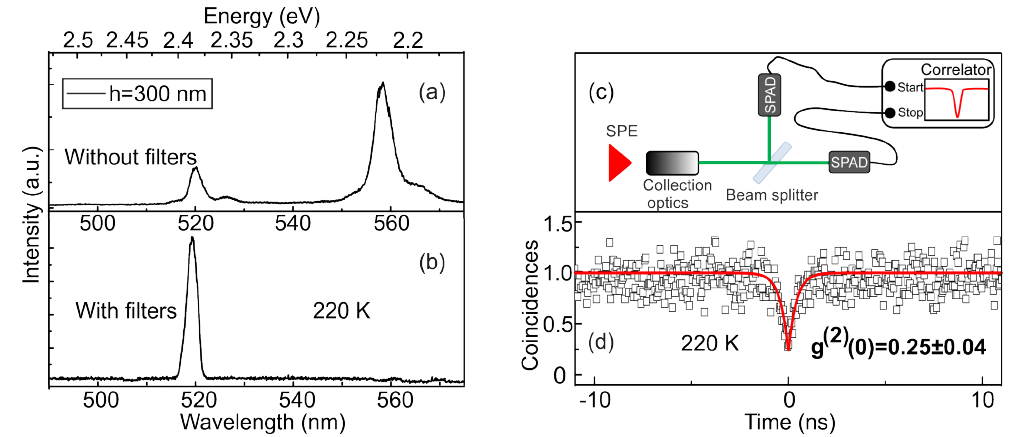
Figure 4. ( a , b ) Representative µ –PL spectra of a photonic nanoantenna with CdSe QDs, measured at 220 K without ( a ) and with ( b ) tunable long-pass and short-pass optical filters. ( c ) Schematic representation of the Hanbury Brown and Twiss setup used for measuring the second-order correlation function g ( 2 ) . ( d ) Normalized second-order correlation function g ( 2 ) of single photon emission, measured at 220 K for a spectrally filtered single excitonic line. The obtained value of g ( 2 ) (0) is